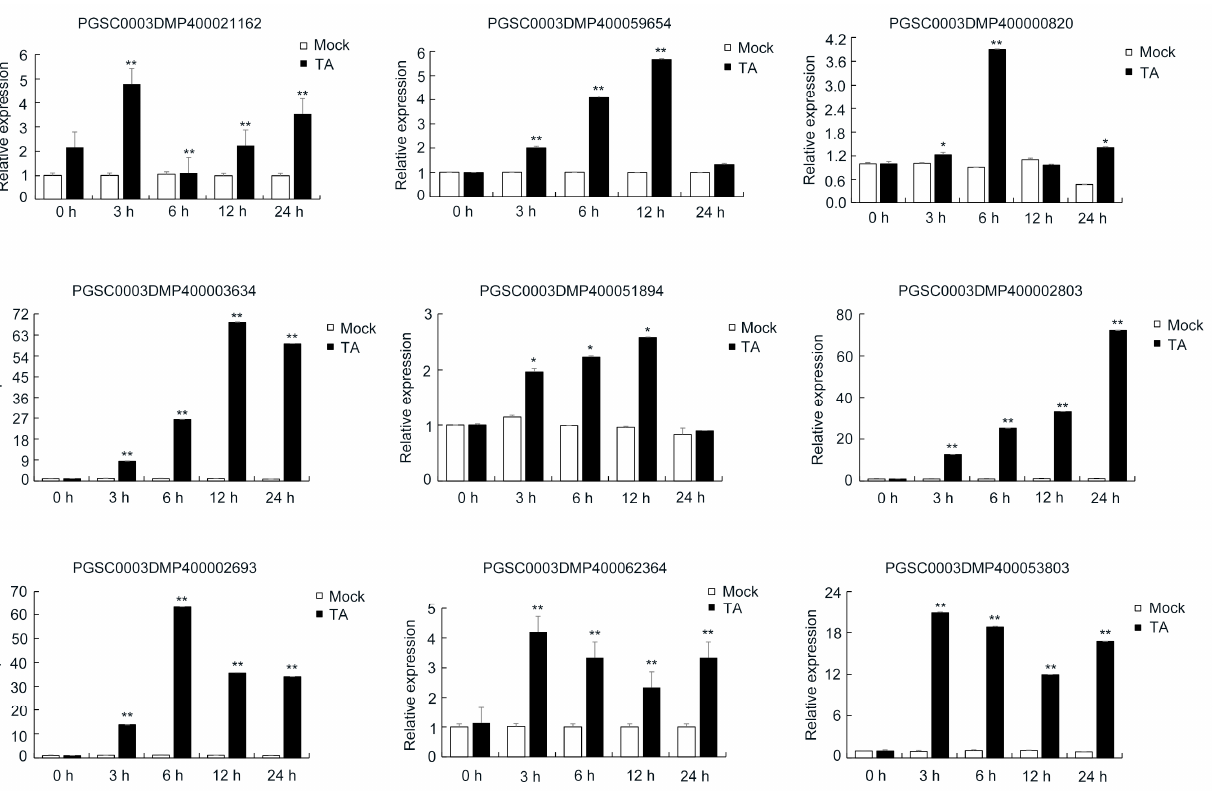
Figure 8. Analysis of the transcript levels of selected DEPs by qRT-PCR. The asterisks denote statistically significant differences, as determined by a Student’s t -test, * p < 0.05, ** p < 0.01. Three biological repetitions were performed.